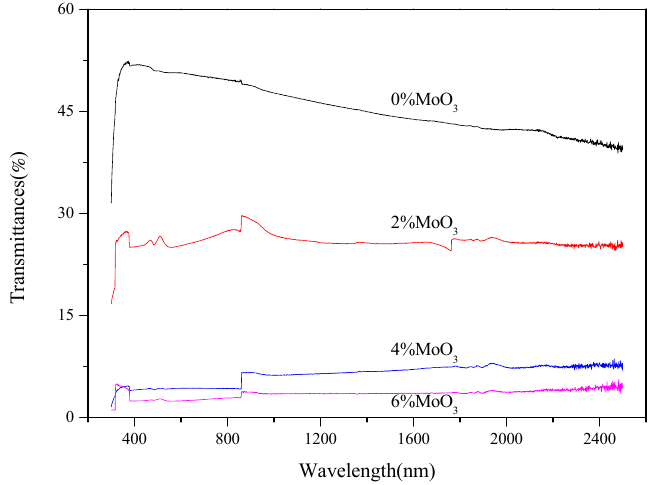
Figure 3. The transmittances of samples with various MoO 3 contents.